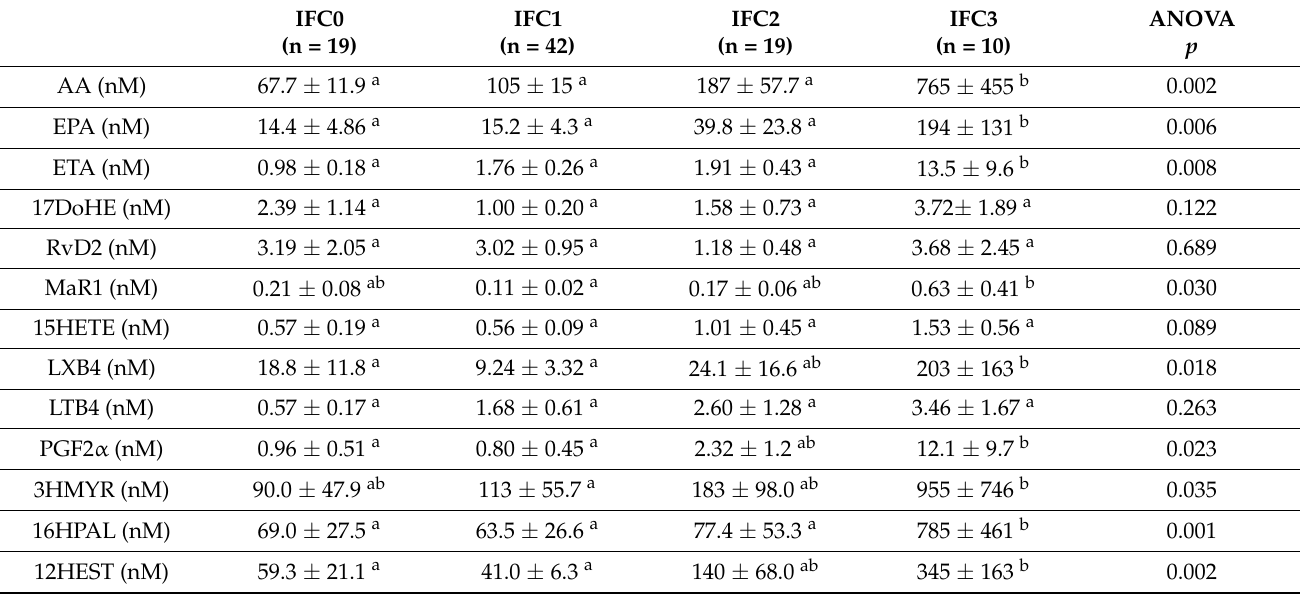
Table 2. Oxylipin and free fatty acid plasma levels of patients with or without non-alcoholic fatty liver disease (NAFLD) according to the intrahepatic fat content (IFC).